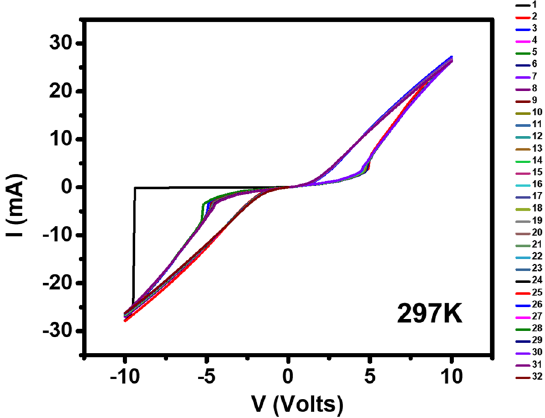
Figure 6. Thirty-two consecutive current vs. voltage I(V) characteristics (biasing the voltage 0 V → − 10 V → + 10 V → 0 V) at 297 K. This temperature was set after cooling from 320